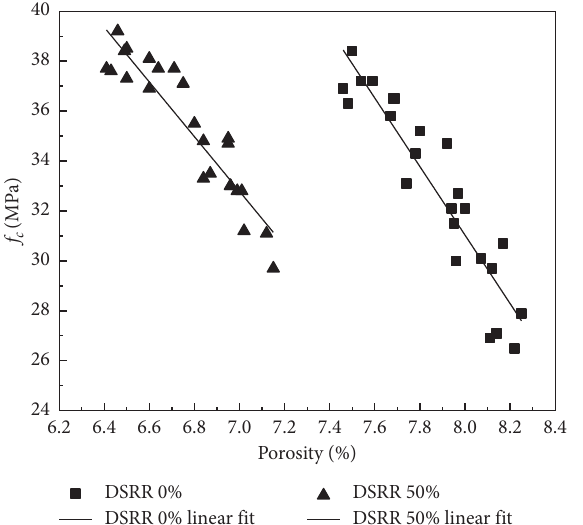
Figure 23: Relation between compressive strength and